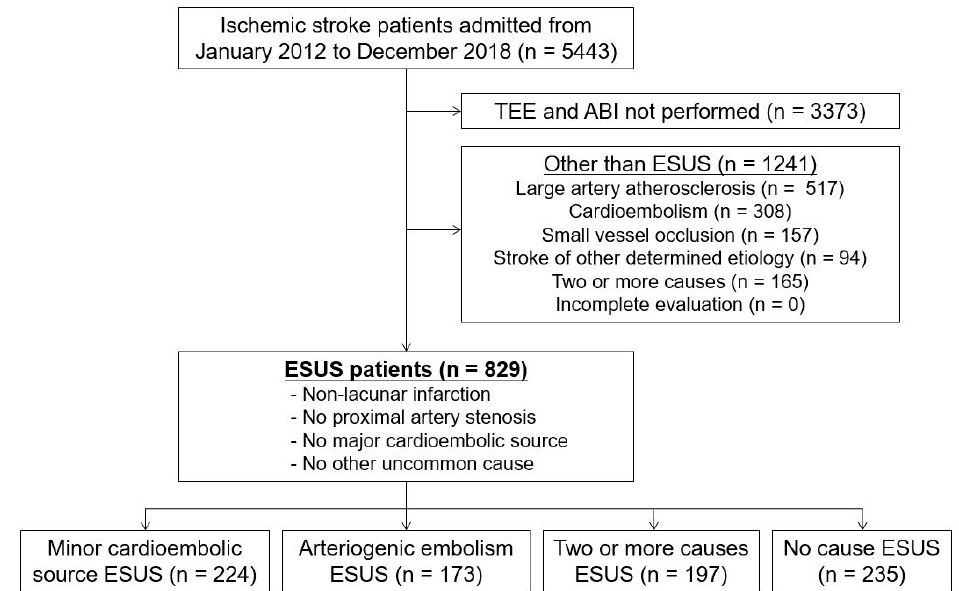
Figure 1. Flowchart of inclusion and exclusion criteria. ABI, ankle-brachial index; ESUS, embolic stroke of undetermined source; TEE, transesophageal echocardiography.